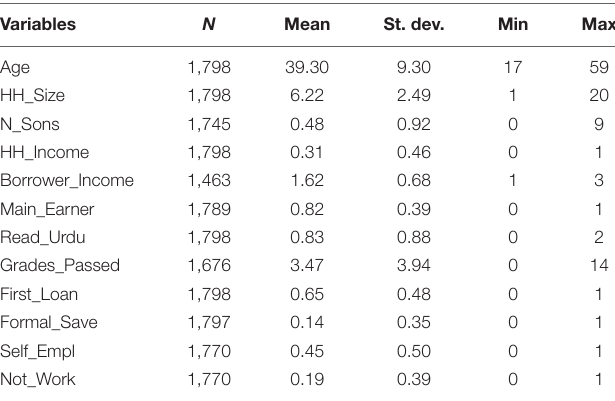
TABLE 1 | Summary statistics final